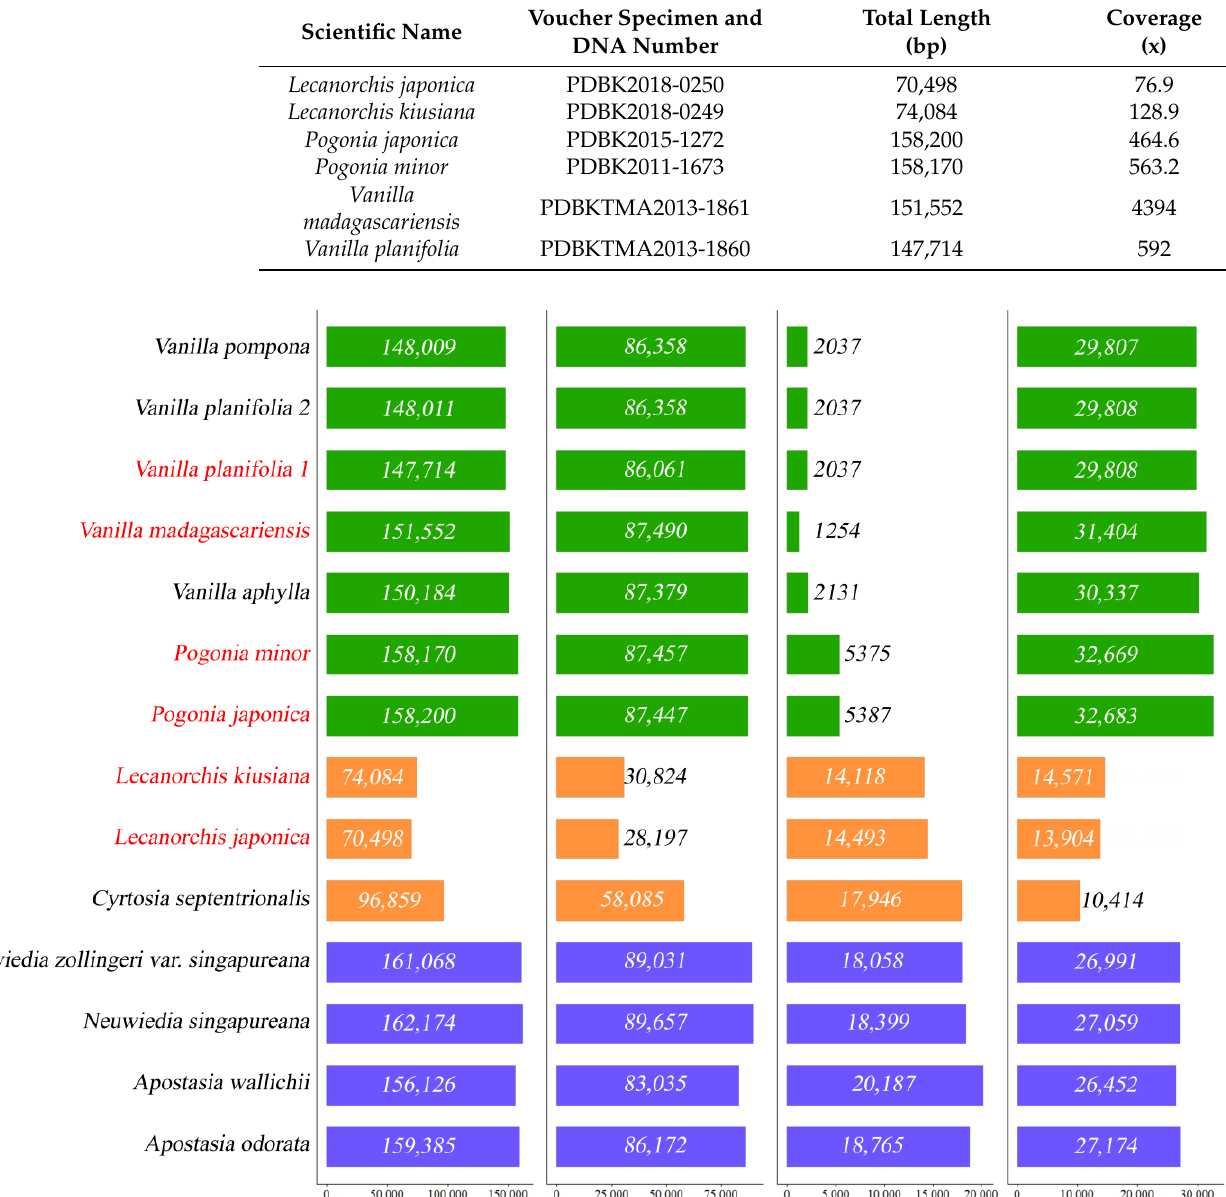
Table 1. The general features of six newly decoded Vanilloideae species.